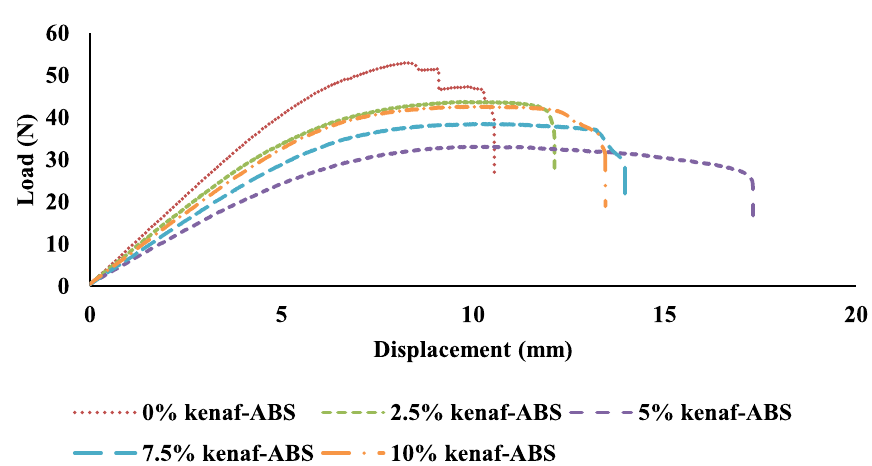
Fig. 6 Load versus displacement for flexural testing